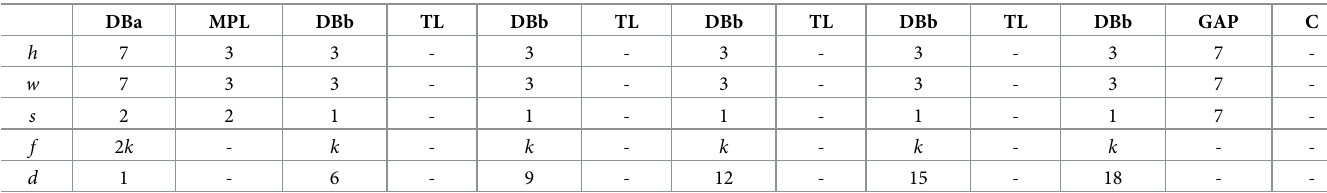
In the first row, the used building components are listed with respect to their placement in the network (the first block is the leftmost one); where DBa and DBb are the basic and the bottleneck versions of the dense blocks; MPL is the max pooling layer; TL is the transition layer, GAP denotes the global average pooling, and C is used for